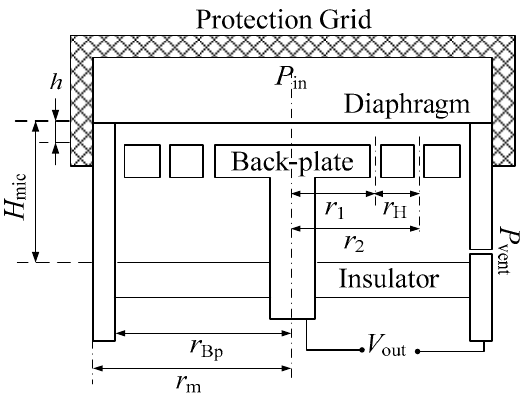
Figure 7. Assembly drawing of a condenser microphone.